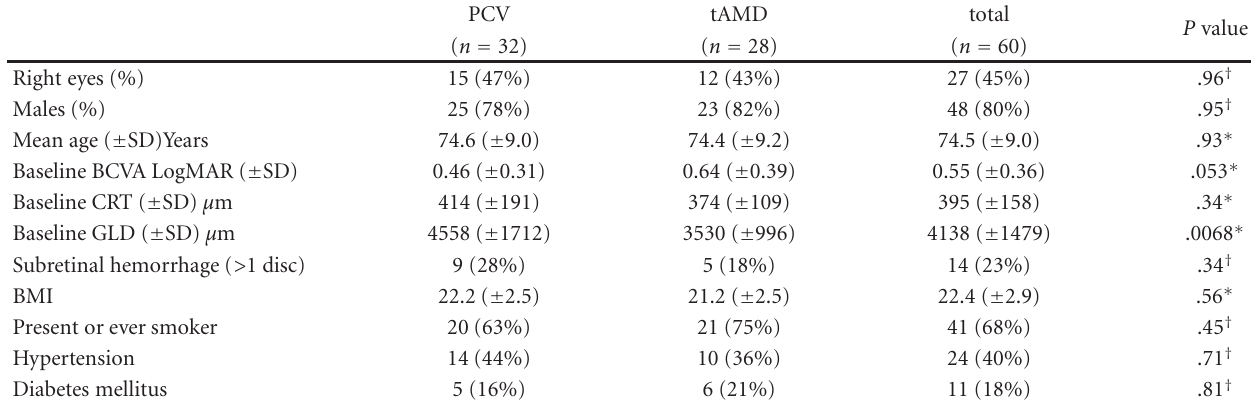
Table 1: Data summary of the participants stratified by AMD phenotype.